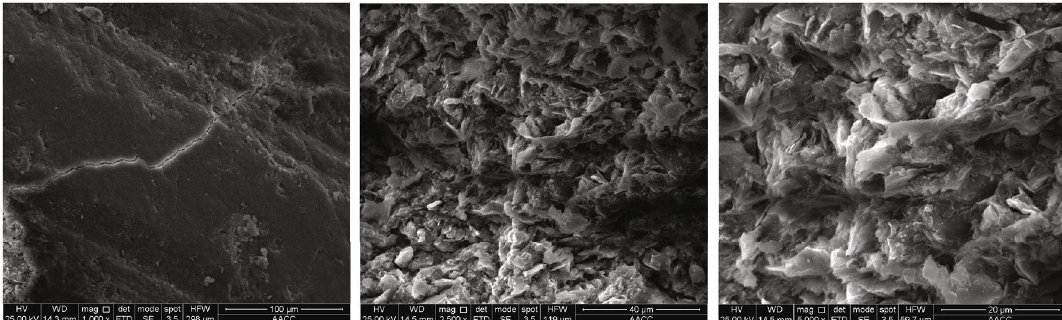
Figure 3: SEM photomicrographs of